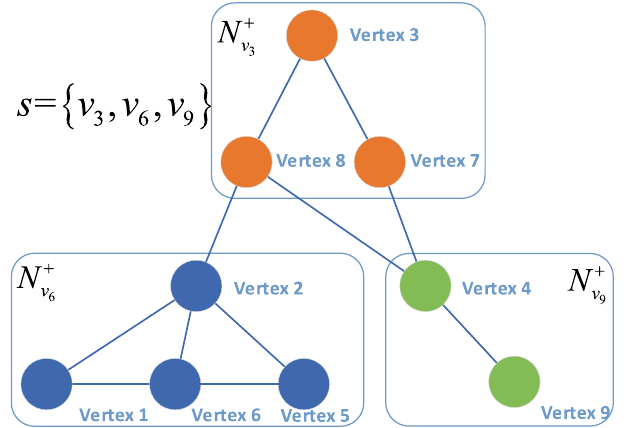
Figure 7. Isolate set. One of the isolate sets in the example is set s , which contains vertices v 3 , v 6 and v 9 . The sets N + N + N + v 3 , v 6 and v 9 are dependency sets of vertices